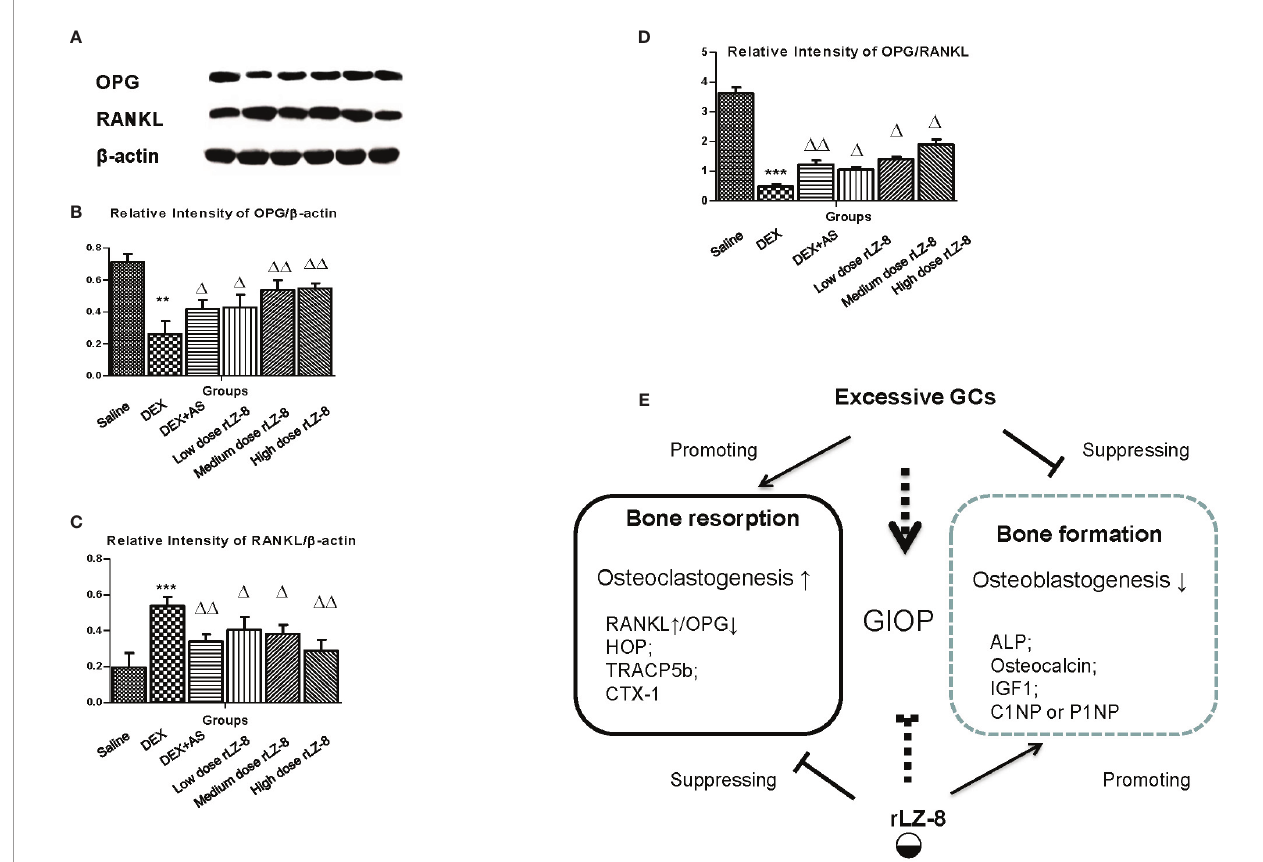
FIGURE 6 | In fl uence of rLZ-8 on protein expression level of OPG and RANKL in bone tissue. (A) Bands of anti-OPG, anti-RANKL, and anti- b -actin in rat femur bone by western blot. From the left to the right, the bands are from blank control group, GIOP model group, positive control group, low dose of rLZ-8 group, medium dose of rLZ-8 group and high dose of rLZ-8 group respectively. (B) Relative expression level of OPG/ b -actin in each group. (C) Relative expression level of RANKL/ b -actin in each group. (D) Relative expression level of OPG/RANKL in each group. (E) Working model of rLZ-8 on GIOP rats. rLZ-8 in fl uences both the bone formation and bone resorption processes. Compared with the blank control group, ** stands for P < 0.01 and *** stands for P < 0.005; Compared with the model group, △ stands for P < 0.05 and △△ stands for P <